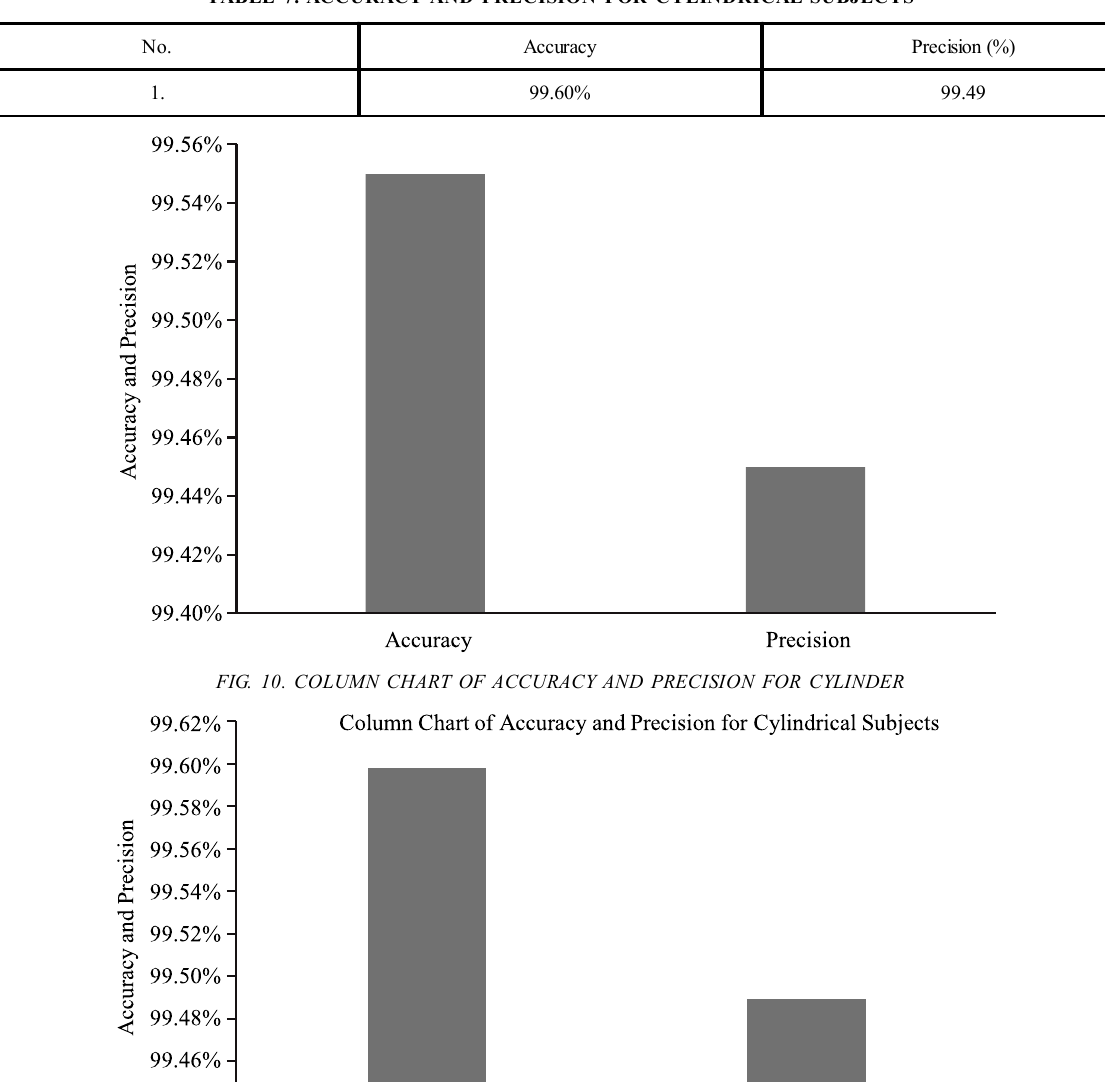
TABLE 7. ACCURACY AND PRECISION FOR CYLINDRICAL SUBJECTS